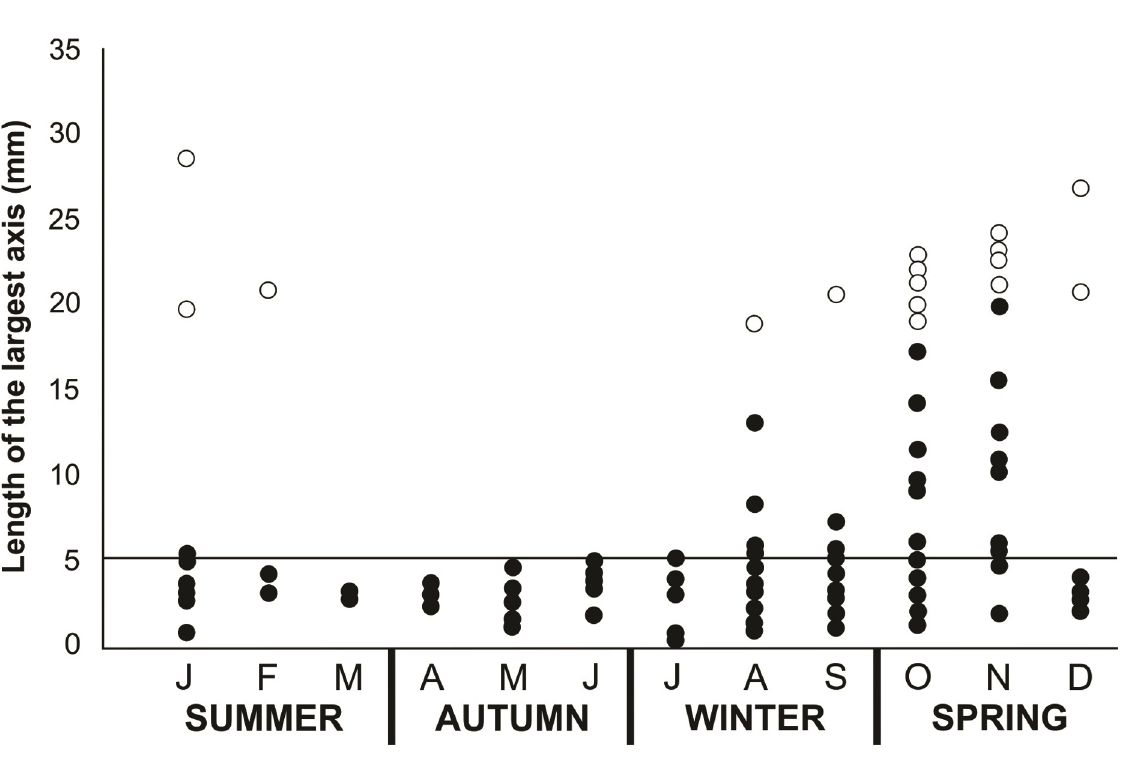
Figure 2. Monthly variation in the length of the largest axis of the largest follicles (black circle) and eggs (white circle) of Erythrolamprus jaegeri coralliventris from Brazilian coastal Pampa, state of Rio Grande do Sul. The horizontal line represents the length of the largest axis from which the follicles are considered in secondary vitellogenesis (5